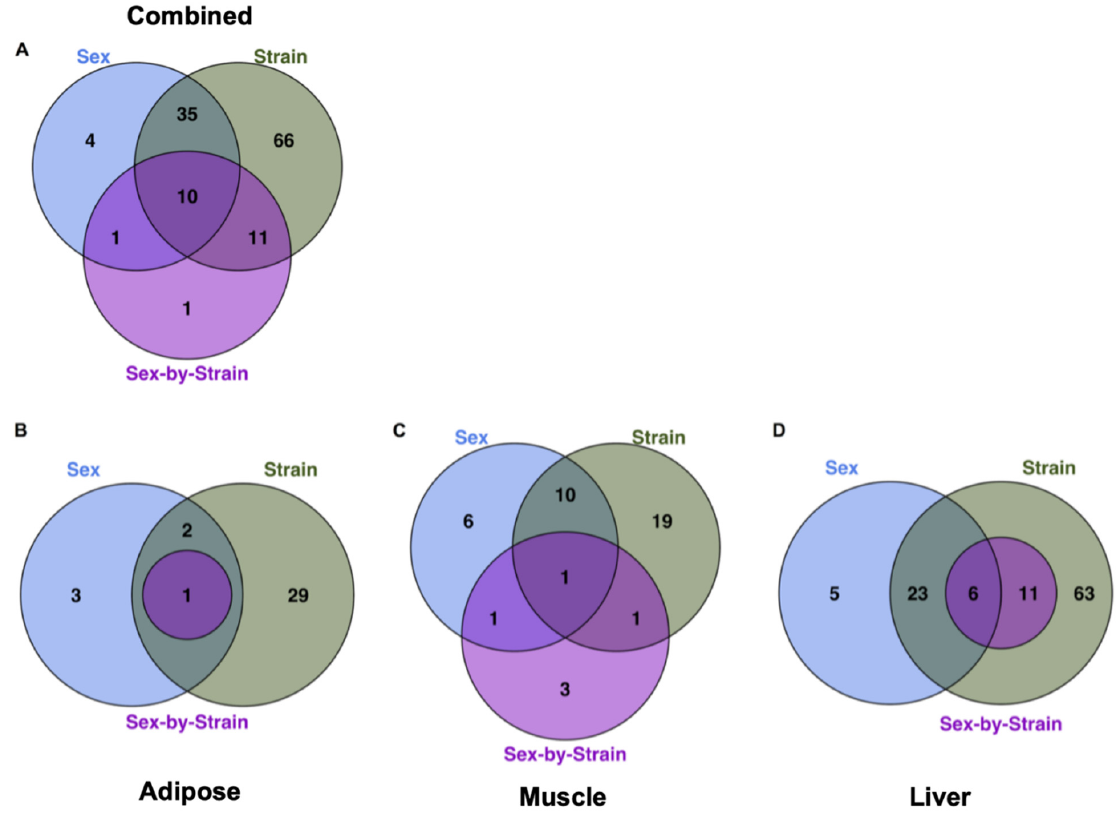
Figure 2. Relative impact of sex, strain, and sex-by-strain interactions on tissue metabolomes. ( A ) The number of metabolites that differed significantly by strain, based on ANOVA (FDR < 0.05), across tissues. The number of metabolites that differed significantly by sex, strain, and sex-by-strain interaction in ( B ) adipose, ( C ) muscle, and ( D )